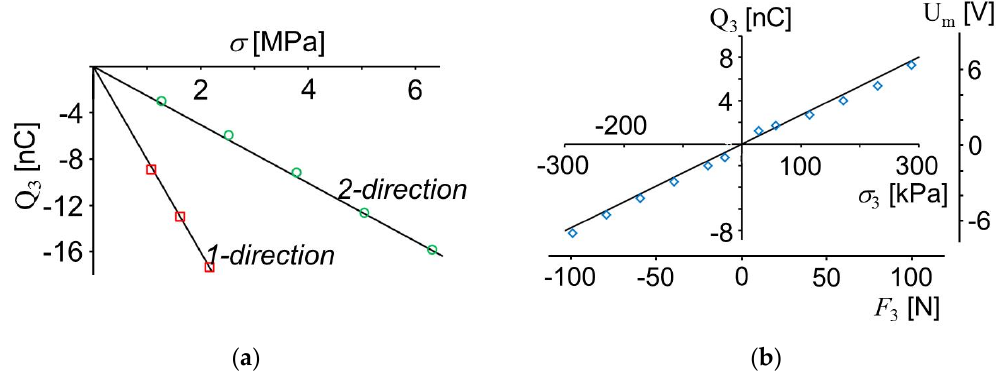
Figure 5. Voltage measured with a PVDF sensor and charge generated as a function of force and pressure exerted in ( a ) 1- and 2-direction, and ( b ) normal to the sensor, in 3-direction.